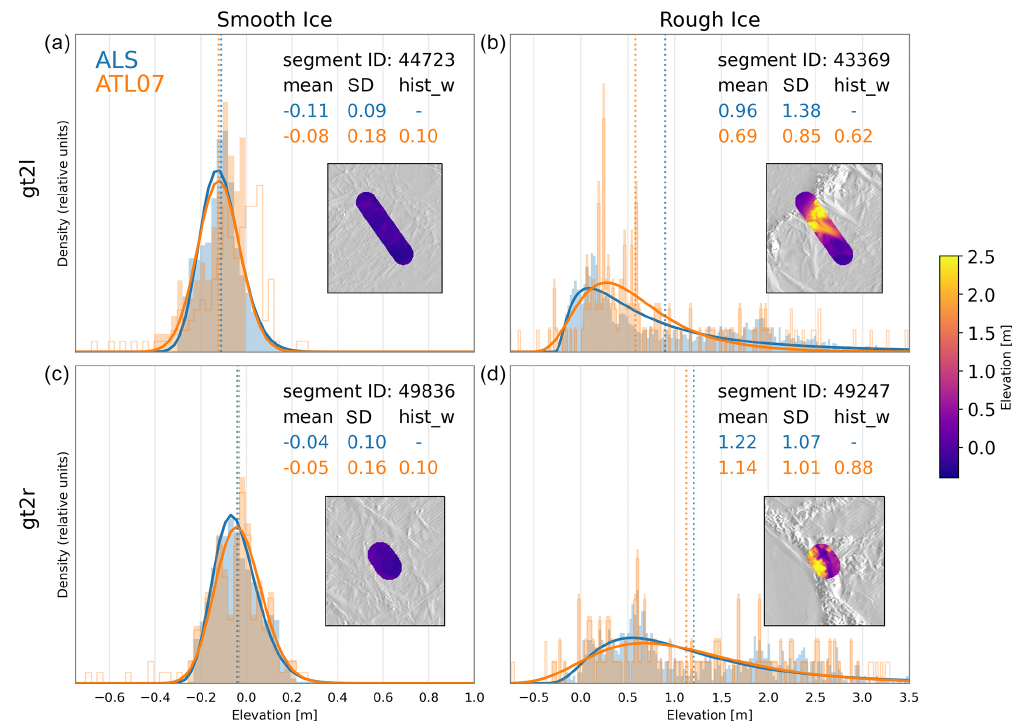
Figure 6. Example ATL07 segments and photon heights that comprise each segment, compared with ALS within-segment elevations. Ex- ample segments are chosen to represent relatively smooth ice (a, c) and rough ice (b, d) from the weak beam gt2l (a, b) and the strong beam gt2r (c, d) . The orange histograms (bars) show the elevation distributions from the ATL07 segment, where the filled bars give the trimmed histogram used to derive elevation in the ATL07 product and the unfilled bars give the entire, non-trimmed photon histogram (defined in Sect. 2.2). The associated within-segment ALS elevations are shown as filled blue bars. Bin sizes are 2.5cm for all examples. The trimmed ATL07 and ALS histograms are fitted with a lognormal distribution (solid lines), from which the provided means and standard deviations (in meters) are drawn. The hist_w represents the width of the height distribution within segments in the ATL07 product. Inset plots show the within-segment ALS elevations highlighted on top of the surrounding ALS ice elevations (shown using hillshading).